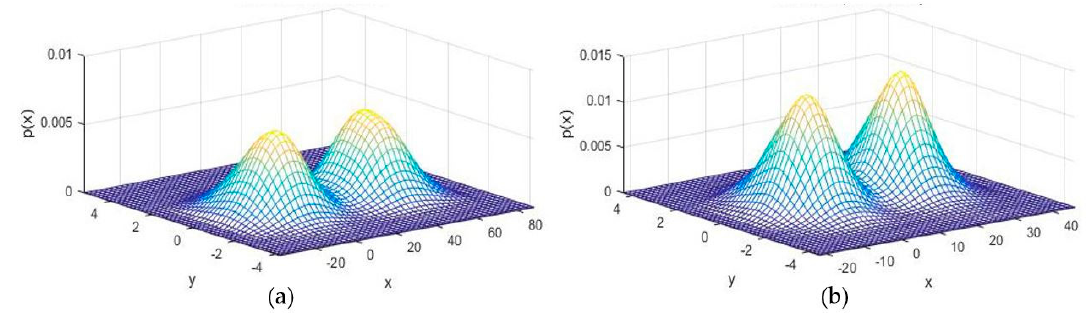
Figure 22. Power density of LED pulse at 2 kHz OOK subcarrier ( a ) and 4 kHz OOK subcarrier ( b ).